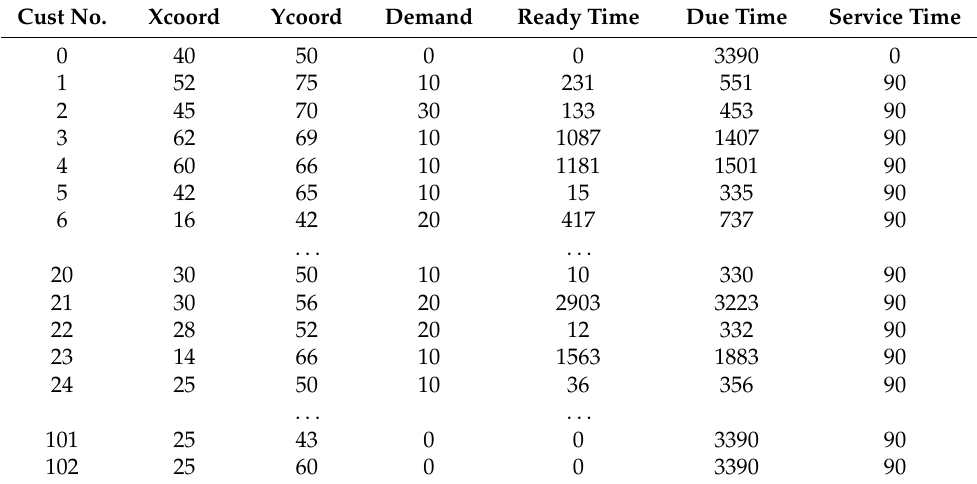
Table 2. The information of partial data in C205.